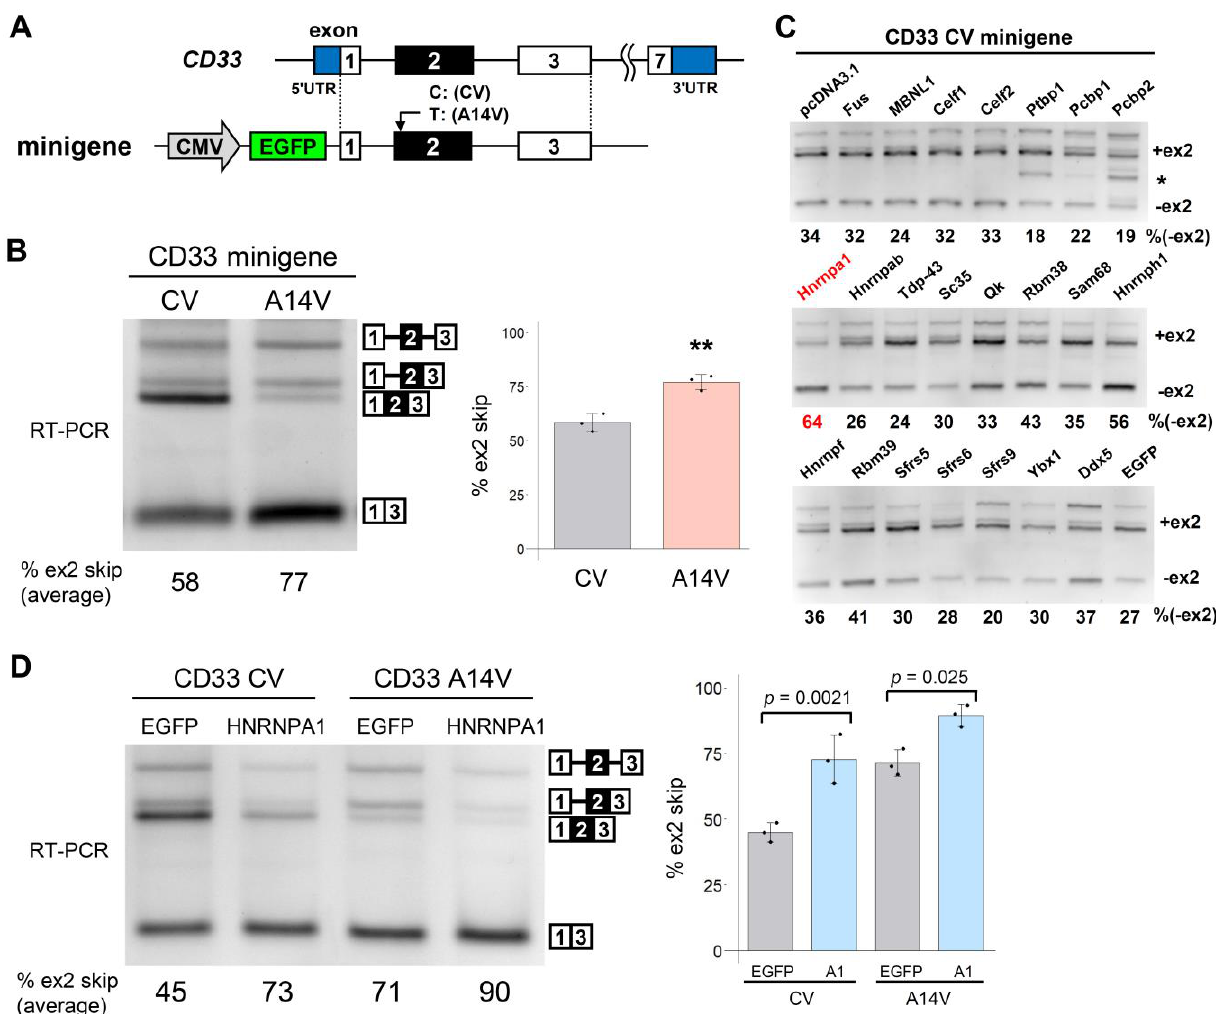
Figure 1. Screening of RNA-binding proteins (RBPs) that regulate the alternative splicing of CD33 exon 2. ( A ) Schematic diagram of the human CD33 minigene. ( B ) Splicing assay of the CD33 minigenes (CV and A14V). A representative agarose gel image of RT-PCR amplification products using the CD33 minigenes ( top ). The bar chart shows the proportion of exon 2 skipping. Error bars represent SD ( n = 3). ** p = 0.0040, two-tailed Welch’s t -test. ( C ) Splicing assay results using the CD33 CV minigene and a panel of RBPs. RBPs were expressed as a fusion with EGFP. Splice products were detected by RT-PCR using agarose gels. The proportion of exon 2 skipping is indicated at the bottom of each lane. ( D ) Splicing regulation of CV and A14V minigenes by human HNRNPA1. The bar chart shows the proportion of exon 2 skipping. Error bars represent SD ( n = 3). Statistical significance was evaluated by Tukey’s test.